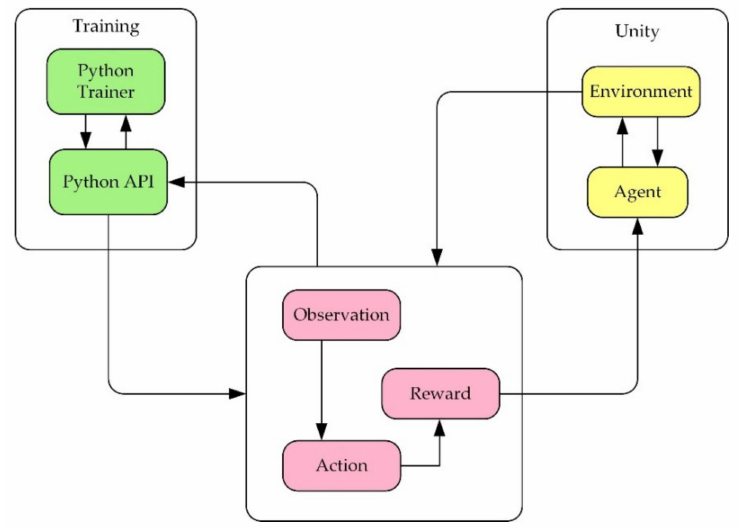
Figure 5. Training logic